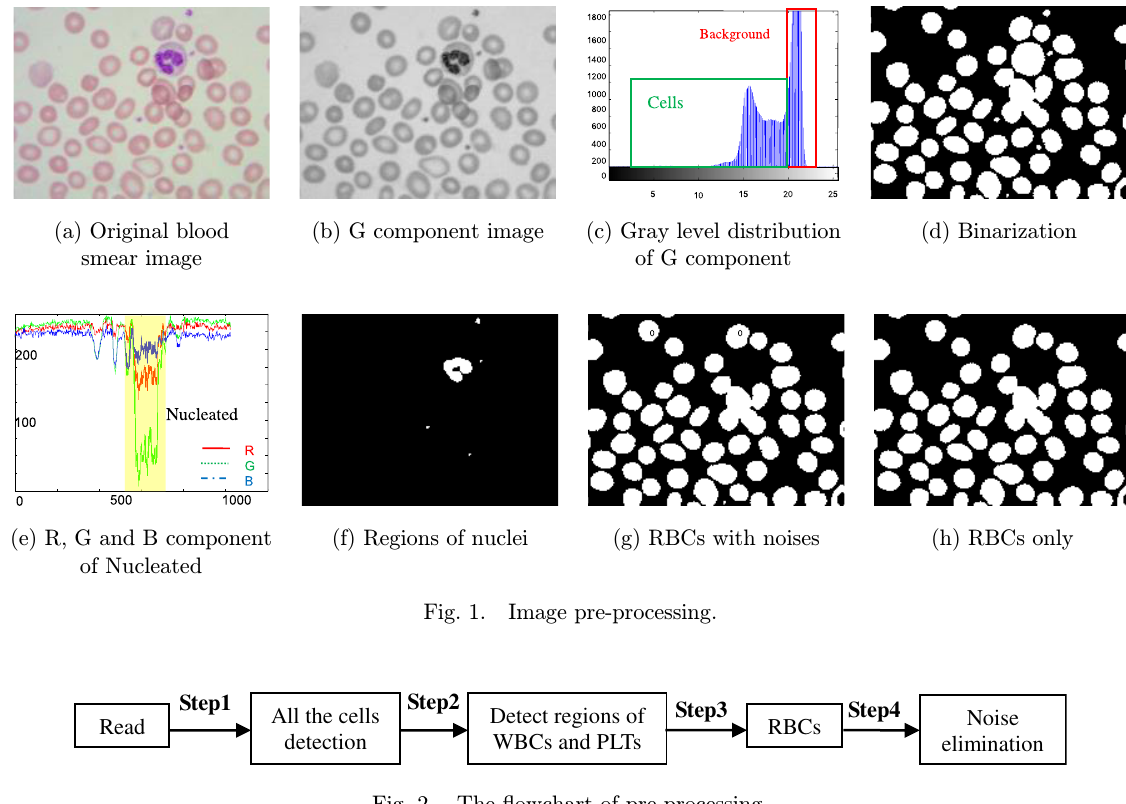
Fig. 2. The °owchart of